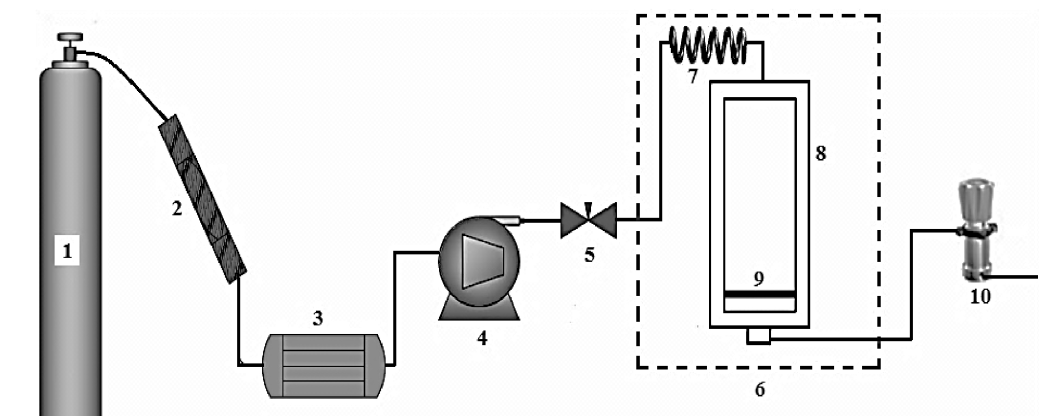
Fig. 1. Schematic diagram of employed SC-CO process; (1) CO cylinder, (2) column consisting of molecular sieve and silica gel, (3) chiller, (4) 2 2 HPLC pump, (5) needle valve, (6) oven, (7) spring coil preheater, (8) stainless steel high pressure vessel, (9) metallic porous filter, (10) BPR